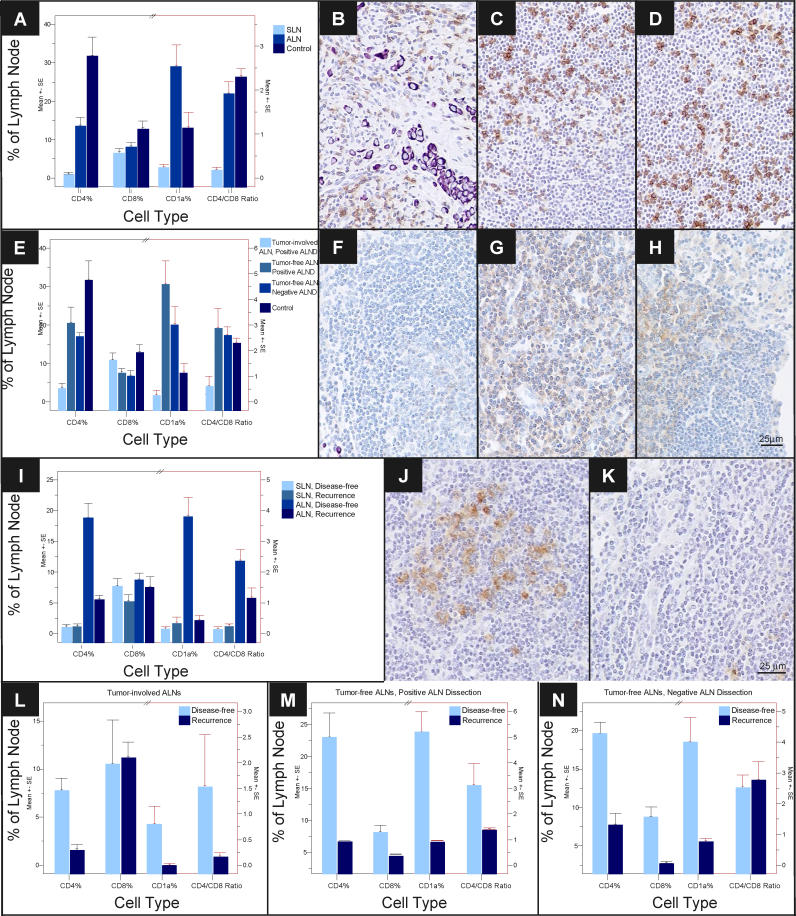
Lymph Node Profile of Sentinel and Axillary Lymph NodesMean and standard error of CD4 and CD8 T cell, CD1a dendritic cell populations as percent of lymph node, and CD4:CD8 cell ratio are shown for (A) SLN (n = 29), ALN (n = 29), and control lymph nodes (n = 10); (E) tumor-involved ALNs (n = 9), tumor-free ALNs (n = 7) from patients with a positive ALND, tumor-free ALNs from patients with a negative ALND (n = 13), and controls (n = 10); (I) SLNs and ALNs stratified by disease recurrence during 5 y of follow-up (11 of 29 with recurrent disease); (L) tumor-involved ALNs stratified by disease recurrence (n = 9); (M) tumor-free ALNs from patients with a positive ALND stratified by disease recurrence (n = 7); and (N) tumor-free ALNs from patients with a negative ALND stratified by disease recurrence (n = 13). Representative 200× images of lymphocyte population (brown staining) and infiltrating tumor (purple staining) by IHC, including CD8 T cells in (B) SLNs, (C) ALNs, and (D) controls; (F) CD4 T cells in tumor-involved ALNs, (G) tumor-free ALNs from patients with a positive ALND, (H) tumor-free ALNs from patients with a negative ALND; and (J) CD1a dendritic cells in ALNs from patients disease-free versus (K) patients who developed recurrence.